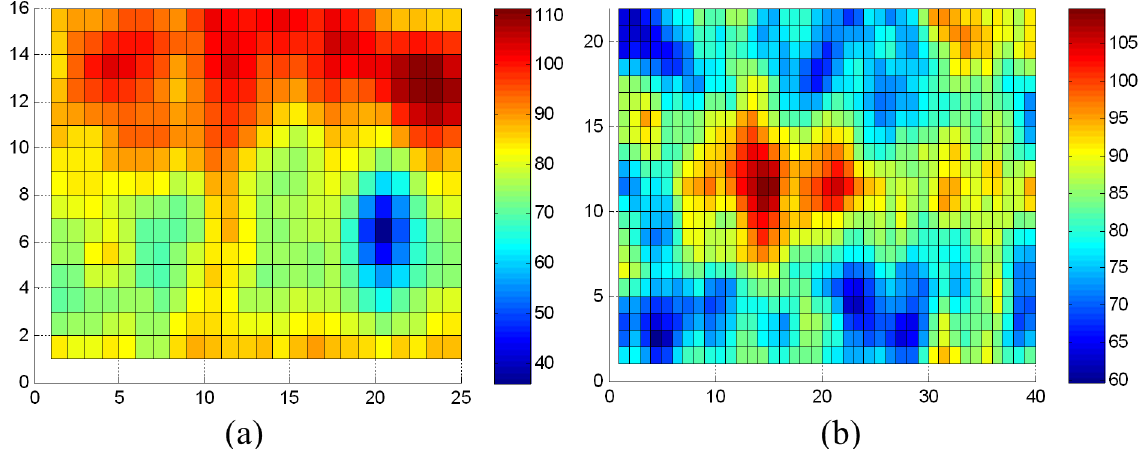
Figure 11. Matching and searching results from Figure 10 using the relevant DF pattern. ( a ) With a fastener; and ( b ) Without